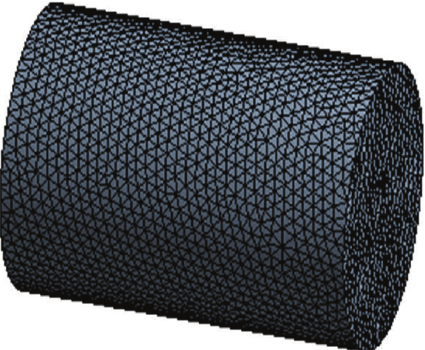
Figure 3: Flow field grid of blisk.